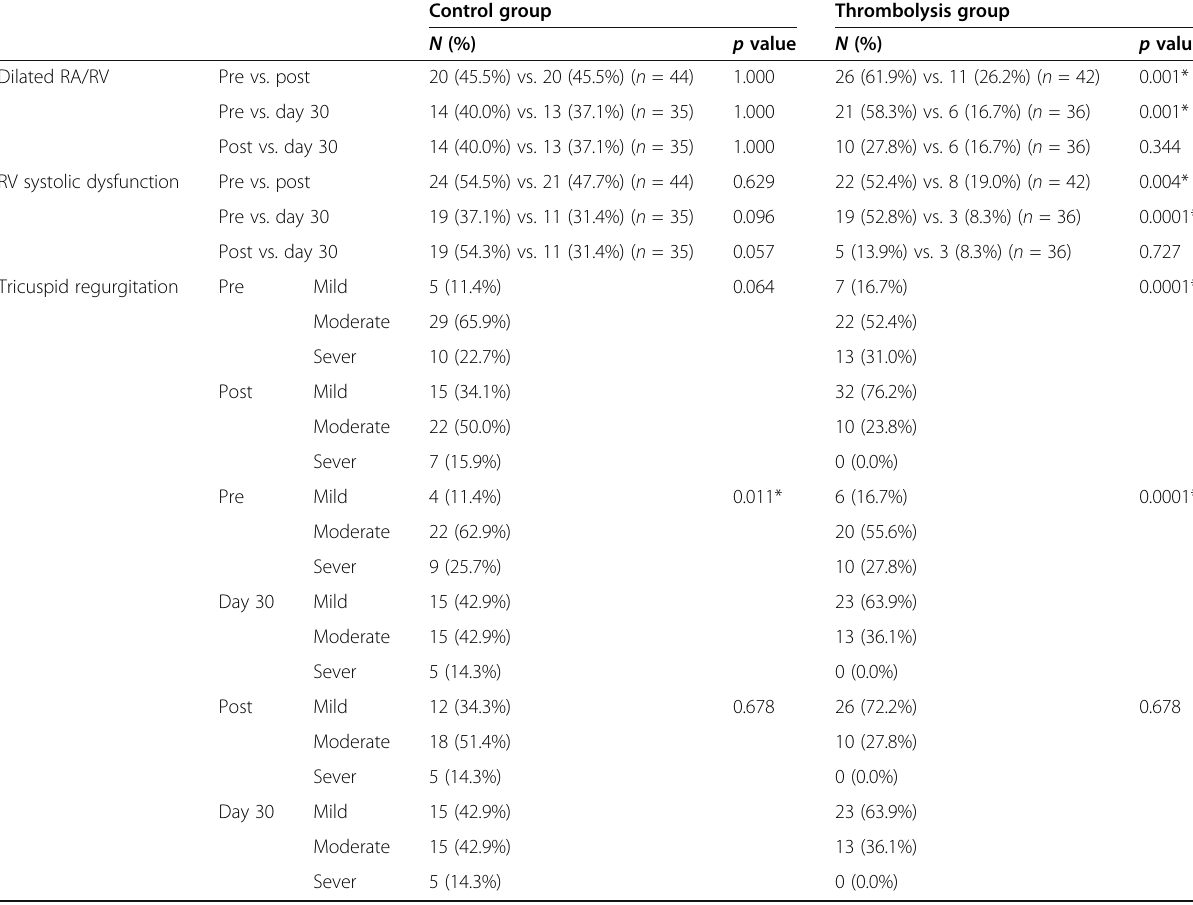
Table 4 Comparison of RV functions in the control group vs. thrombolysis group